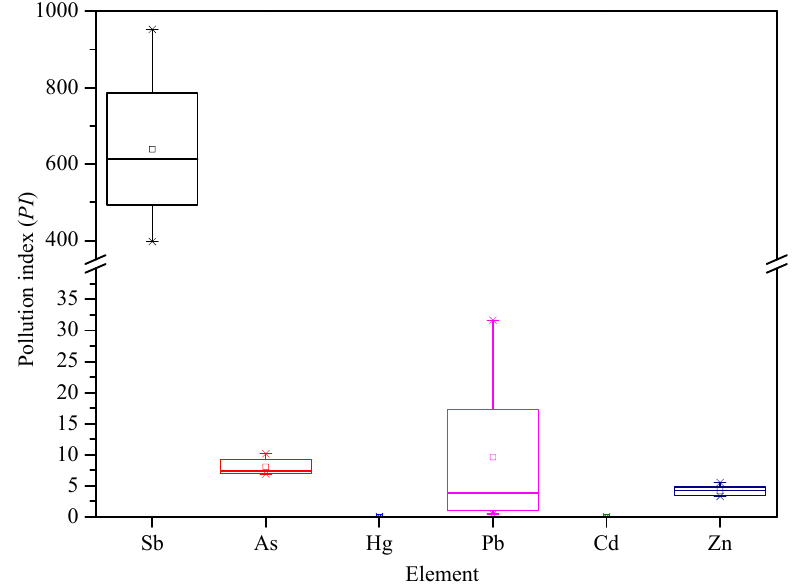
Figure 1. Box-plot showing PI for PTEs in all wastewater samples.